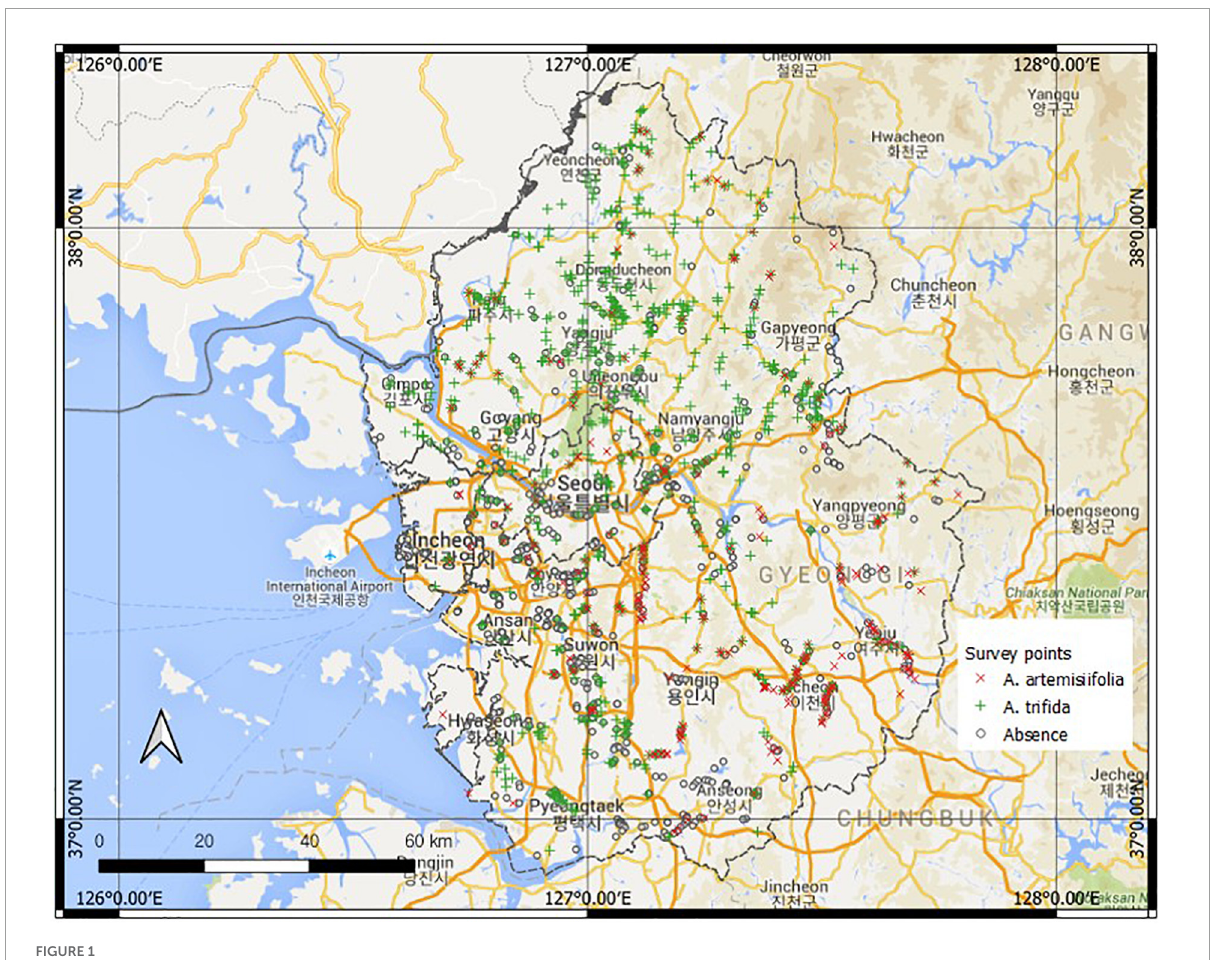
FIGURE1 Study area (Google Maps, 2021) with field survey